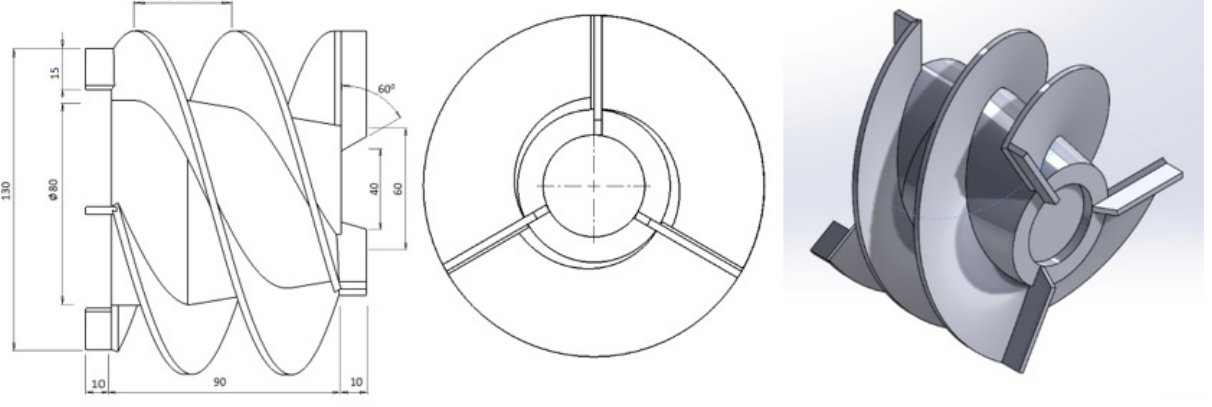
Figure 14. The geometric parameters and isometric view of the rotor with three equidistant blades and pitch length 45 mm.